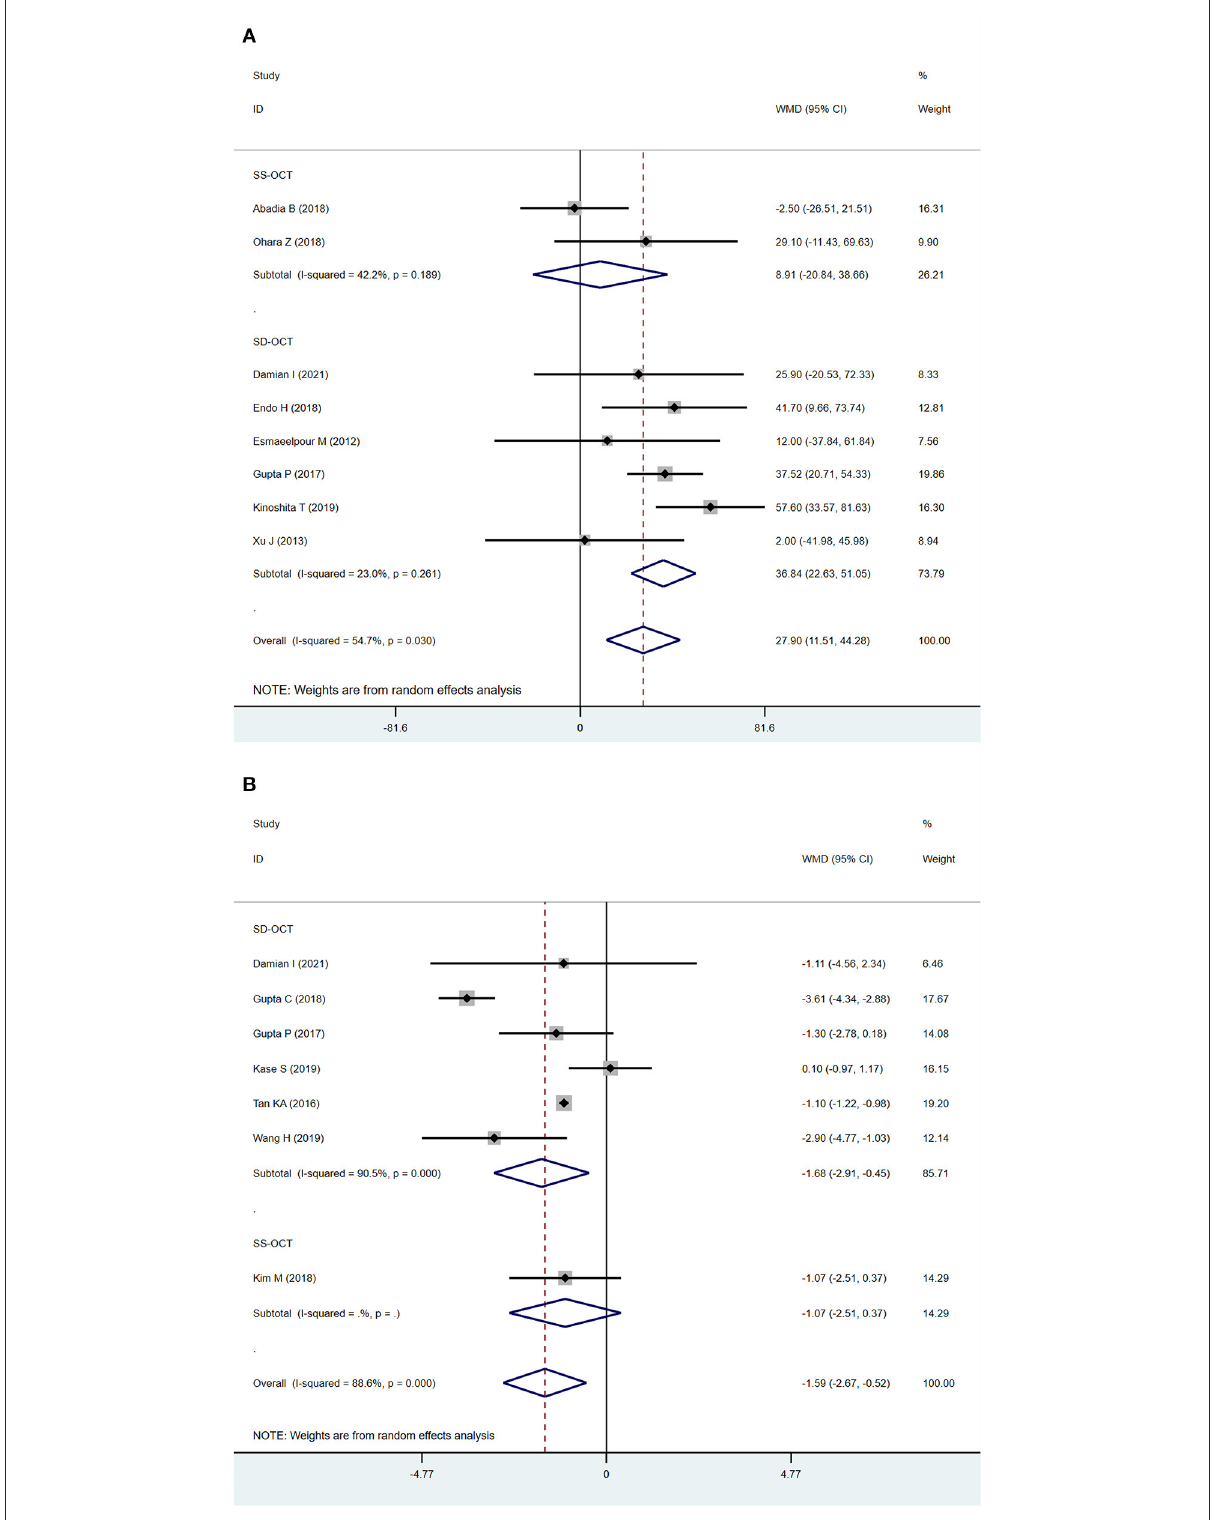
FIGURE4 Sub-analysis of subfoveal choroidal thickness (SFCT) and choroidal vascularity index (CVI) according to OCT instrument (A) SFCT. (B)